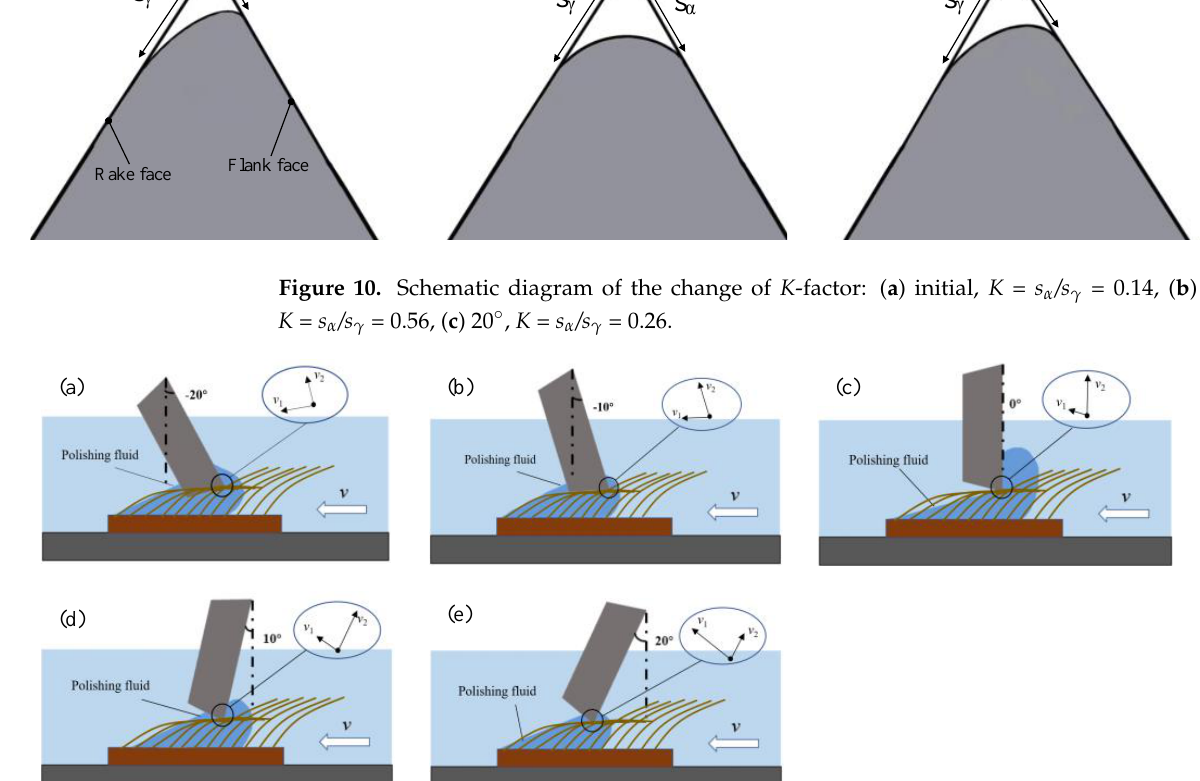
Figure 11. Schematic diagram of cutting edge preparation at different polishing angles: ( a ) – 20°, ( b ) − 10°, ( c ) 0°, ( d ) 10°, ( e ) 20°.